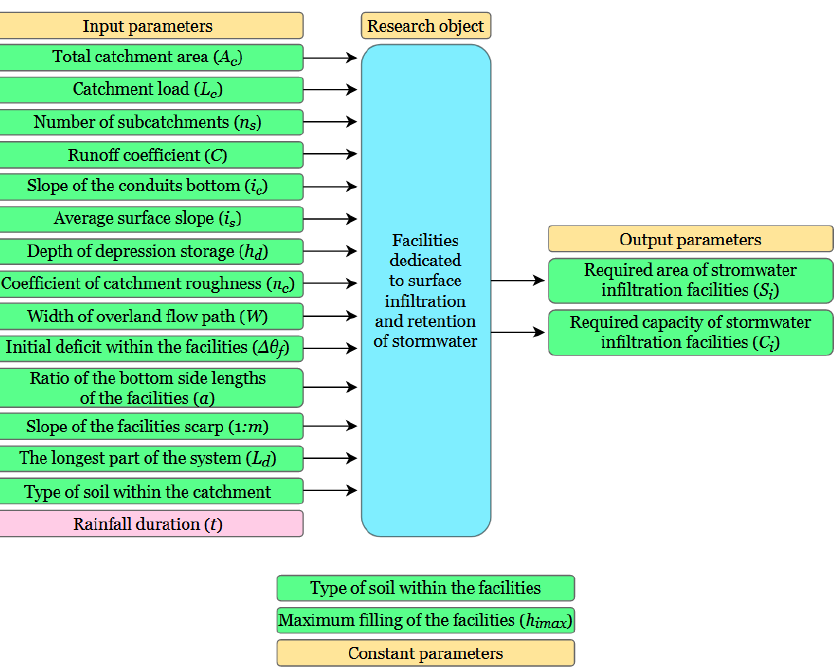
Figure 2. Computational model.